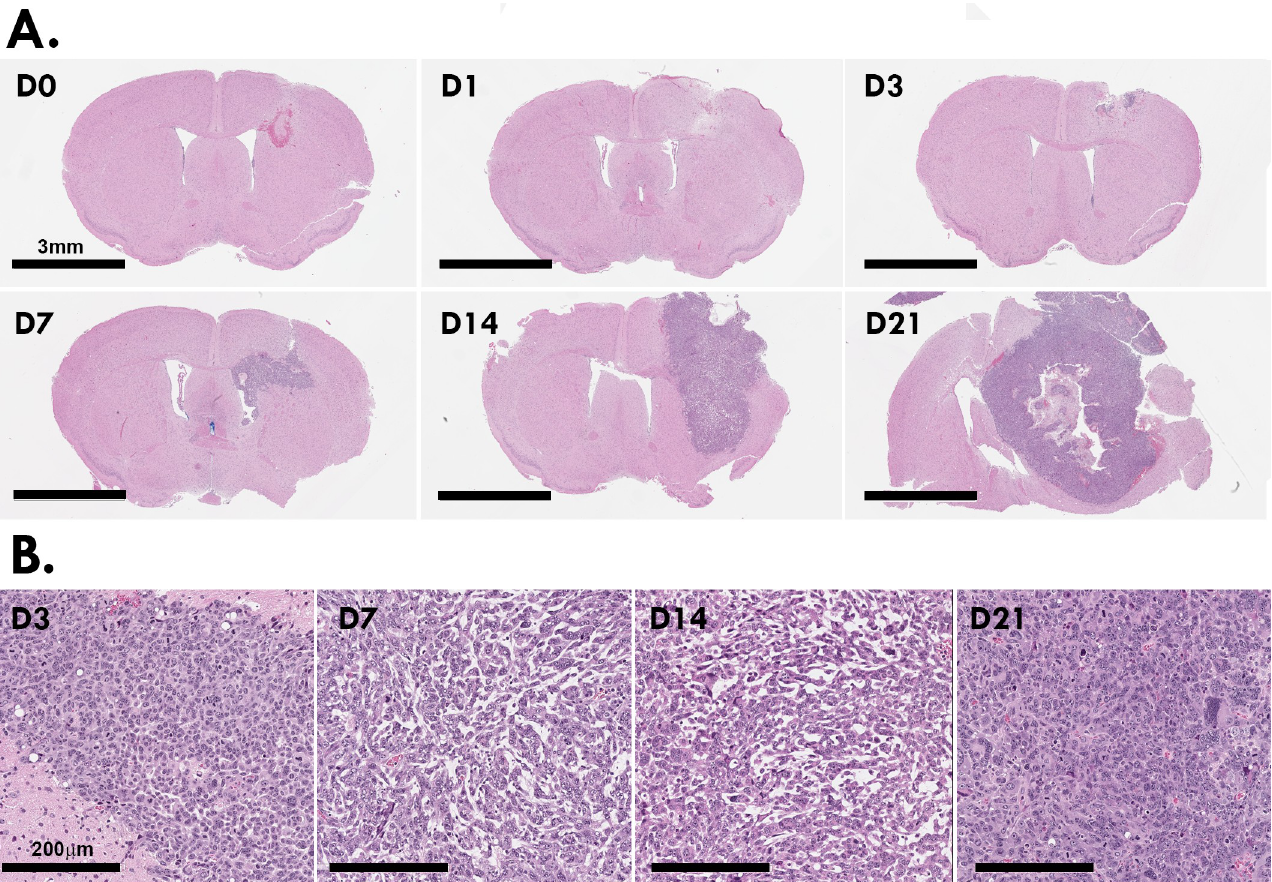
Fig 2. Histopathology of Gl261 gliomas. Four μ m paraffin sections of murine Gl261 brain tumors stained with hematoxylin and eosin Y/eythrosin (A). High resolution of morphology of the Gl261 cells as the tumor grows and matures (B). Images are representative of N = 12 mice per time point.